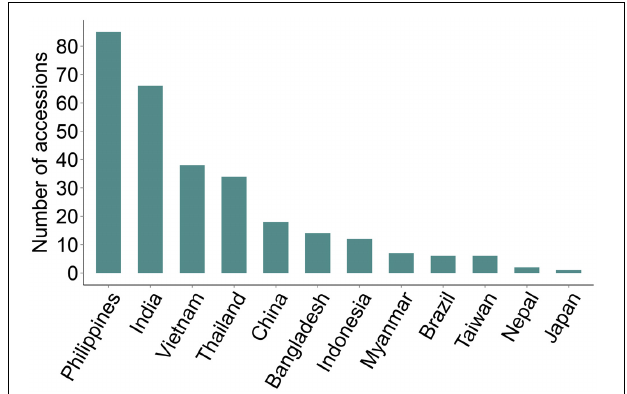
FIGURE 4 | Broad spectrum resistant rice genotypes. Rice accessions showing broad spectrum UBN-resistance against the field mix inoculum as well as against all the five individual rice blast isolates are presented. 289 broad-spectrum resistance rice accessions were identified (scores 0–3), with Philippines, India, Vietnam, Thailand and China being the major contributors. None of accessions from South Korea was identified as broad spectrum resistant.